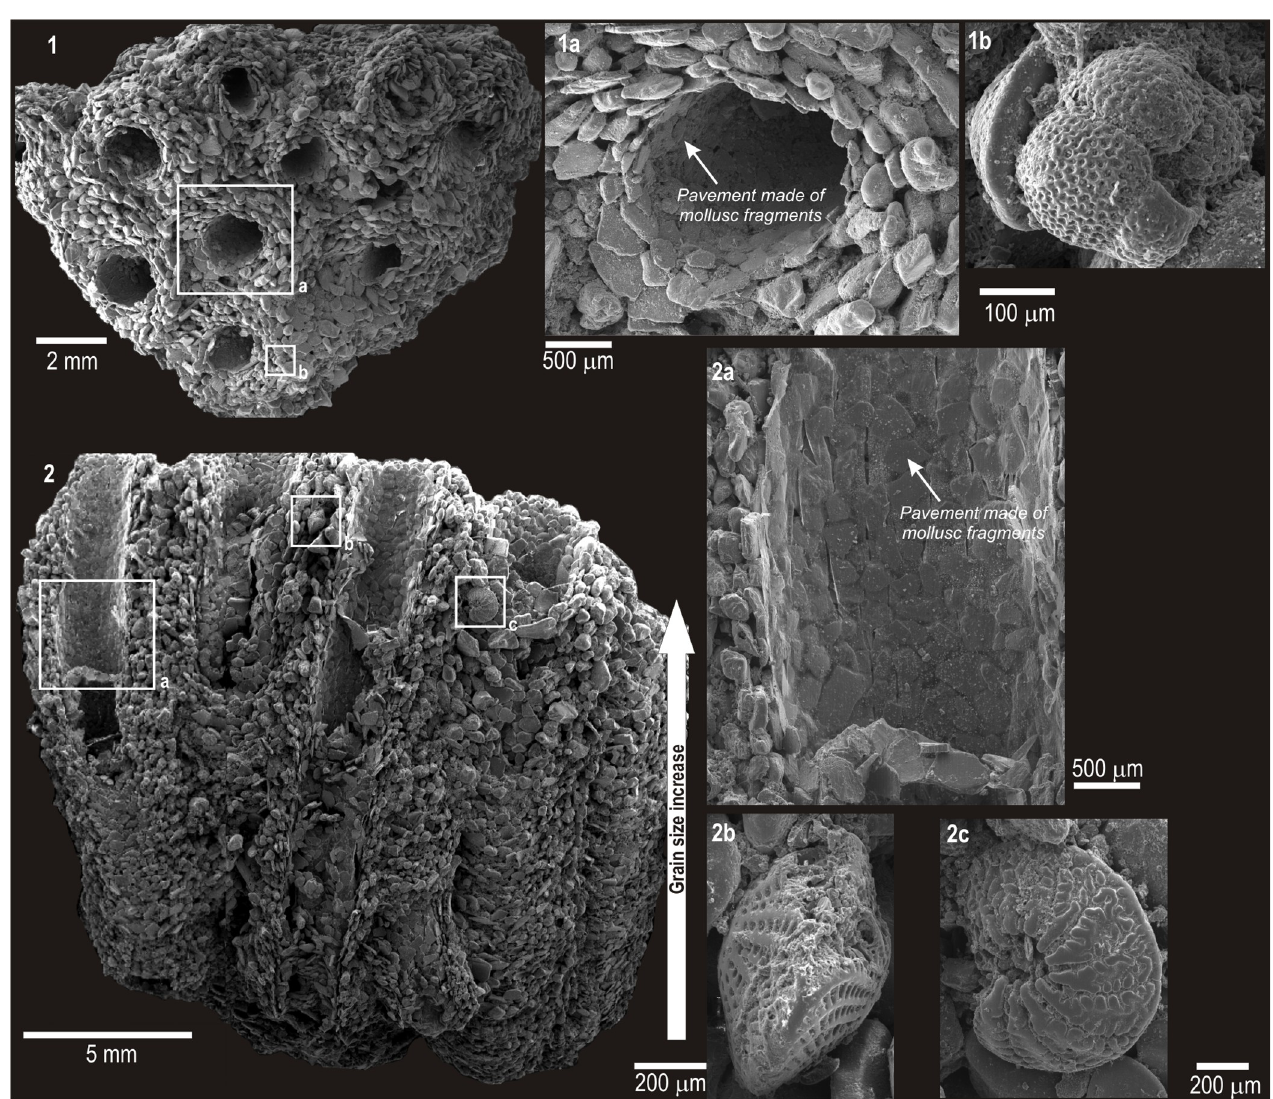
Fig 1. SEM images in secondary electrons of Sabellaria alveolata bioconstruction from site SB. 1. Horizontal view showing the typical honeycomb structure; 2. Vertical view highlighting the internal structure of tubes covered by a smoothed pavement.